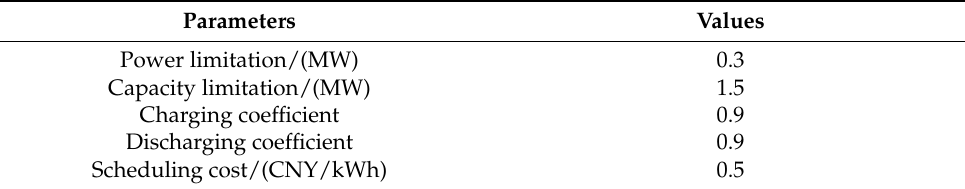
Figure 11. Simulation model of IEEE 33-bus distribution system. Table 1. Basic parameters of the electrochemical energy storage.